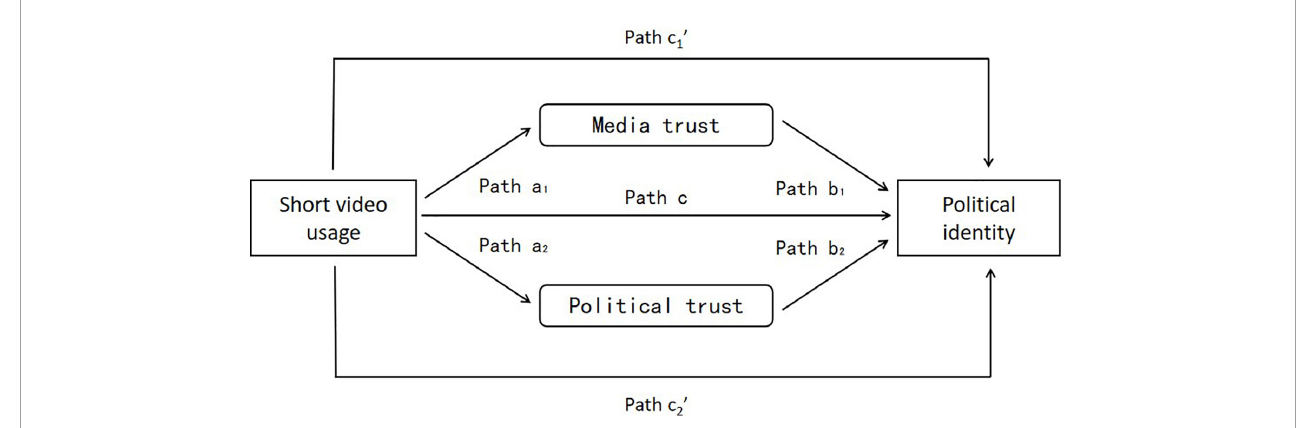
FIGURE1 Model of intermediary effect